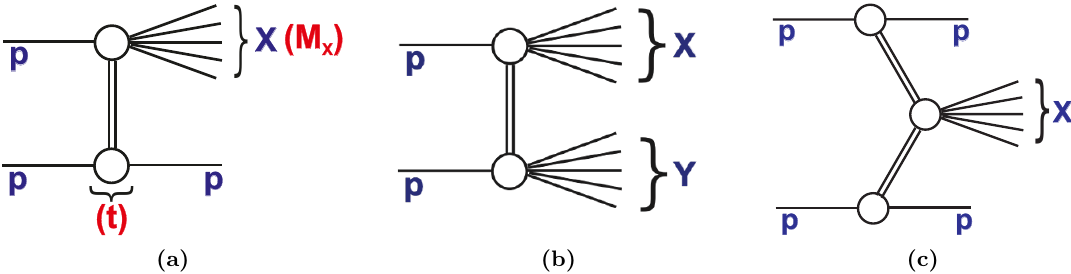
Figure 1. Schematic illustrations of the (a) single di(cid:11)ractive dissociation (SD), (b) double di(cid:11)rac- tive dissociation (DD) and (c) central di(cid:11)raction (CD) processes. The kinematic variables used to describe the SD process (the squared four-momentum transfer, t , and the mass, M X , of the dissociated system X ) are indicated in parentheses in